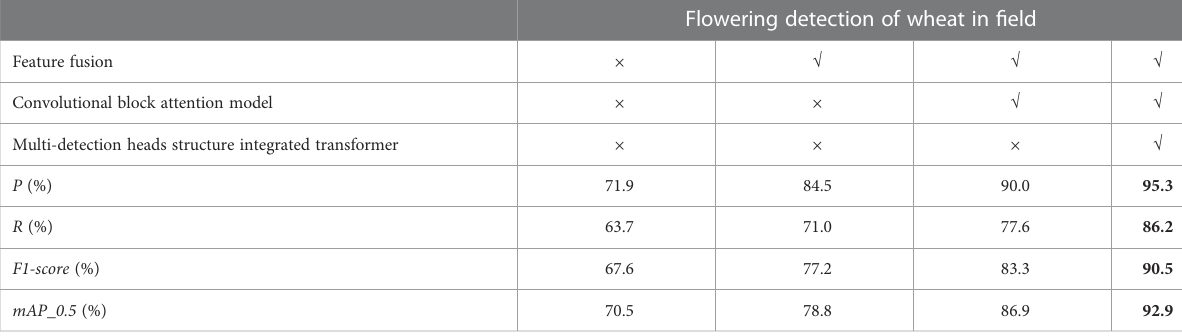
TABLE 5 Detection indexes of the model with different optimization